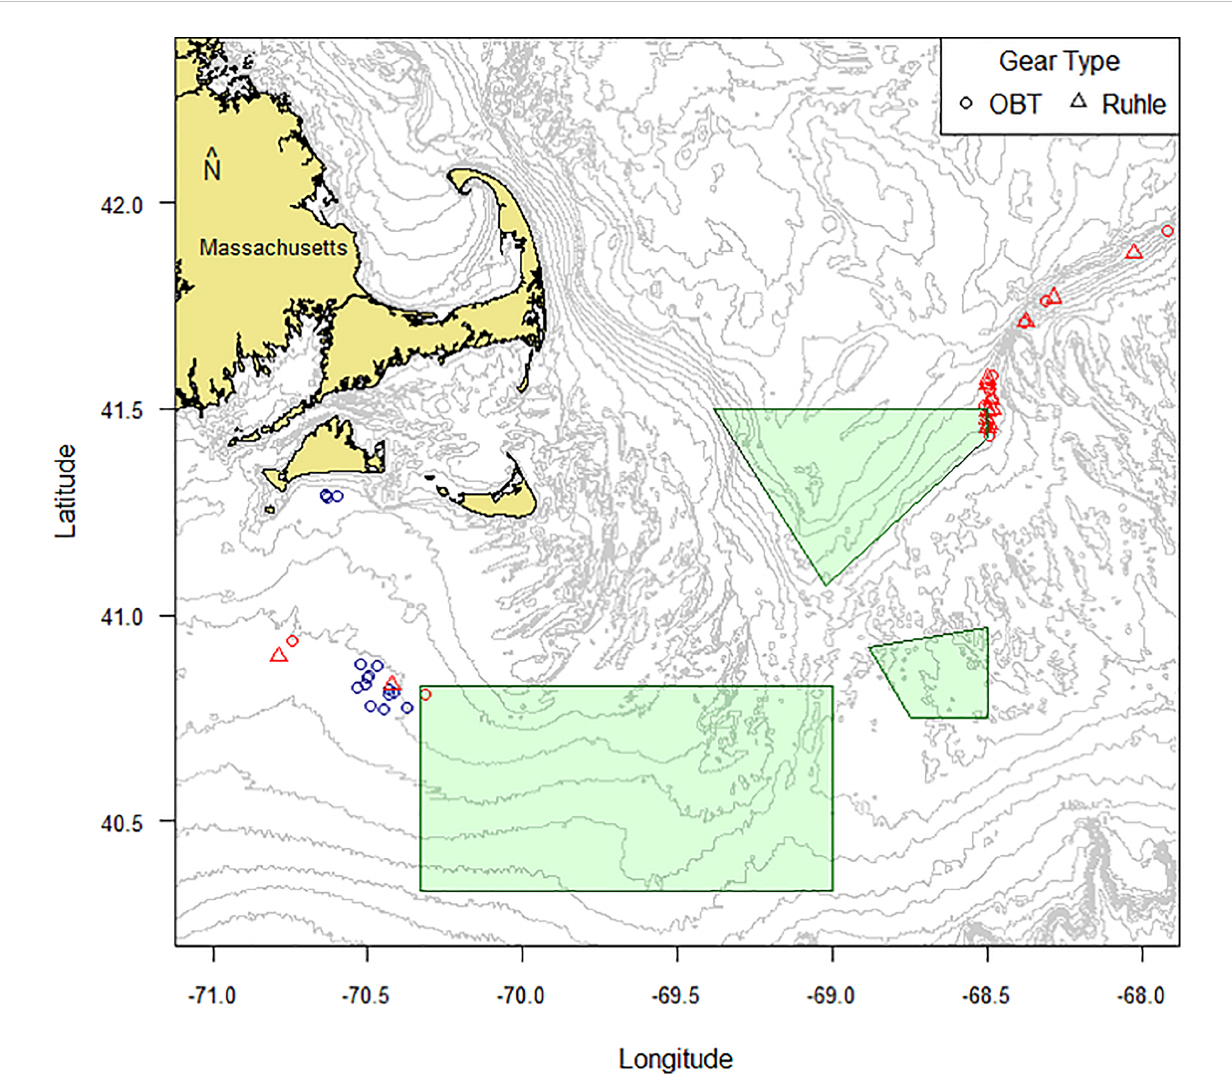
FIGURE 3 Start point locations of tows during trip 1 (blue marks) and trip 2 (red marks). The key shows symbols for gear types used. Sections shaded in green are regulated closed